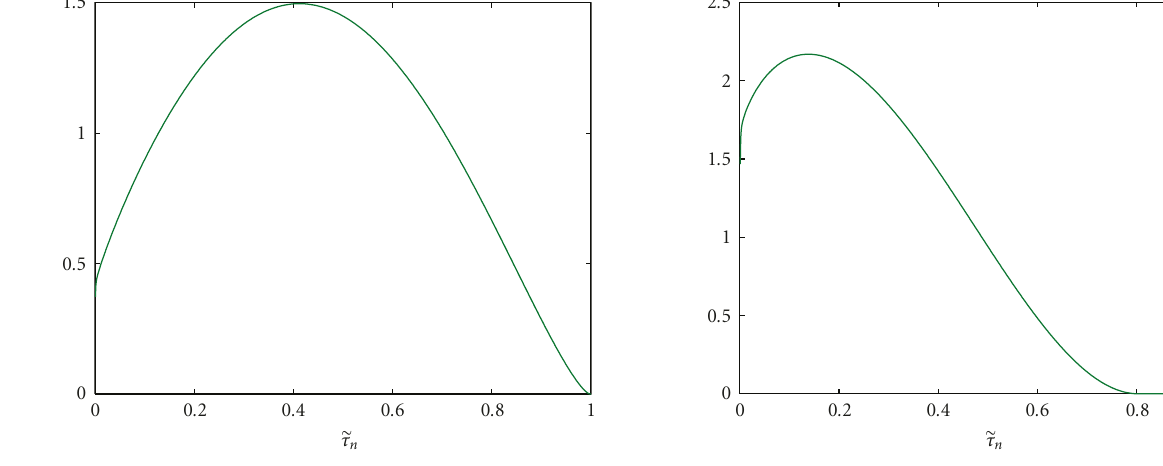
( (cid:9) τ n ) for v min = 0 . 01m / s. n